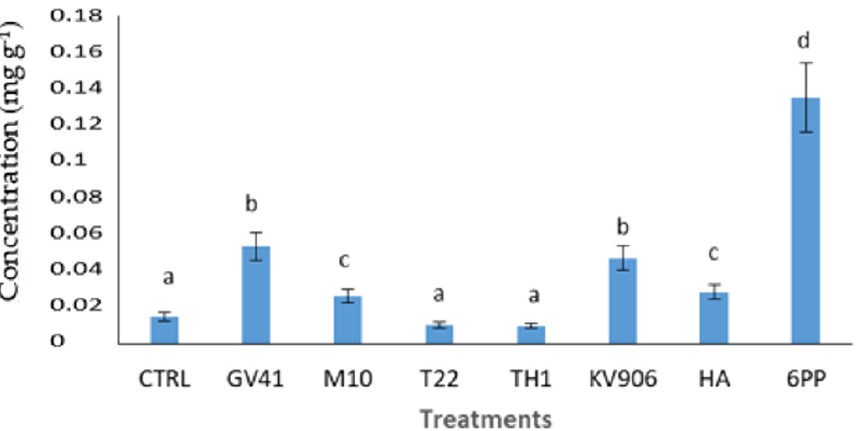
Figure 4. Luteolin content in drupes. Samples are indicated by treatments with Trichoderma strains (TH1, GV41, T22, M10, and KV906) or secondary metabolites (HA and 6PP). Values are the means of three replicates ± SE. Different letters indicate significant differences ( p < 0.05).